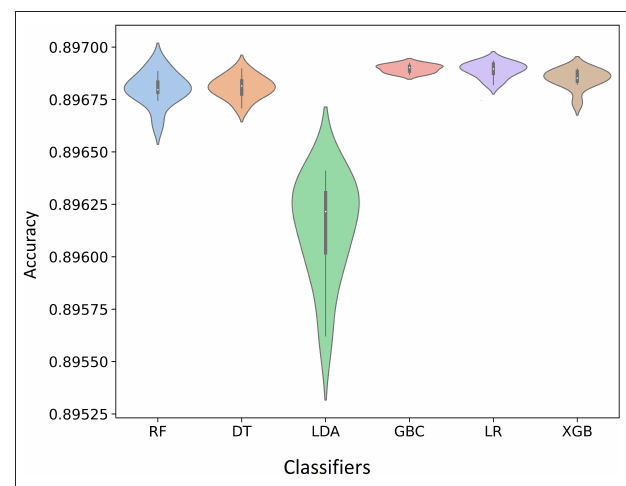
FIGURE 1 | Violin plot of the 10-fold cross-validation (Violin plots representing the entire